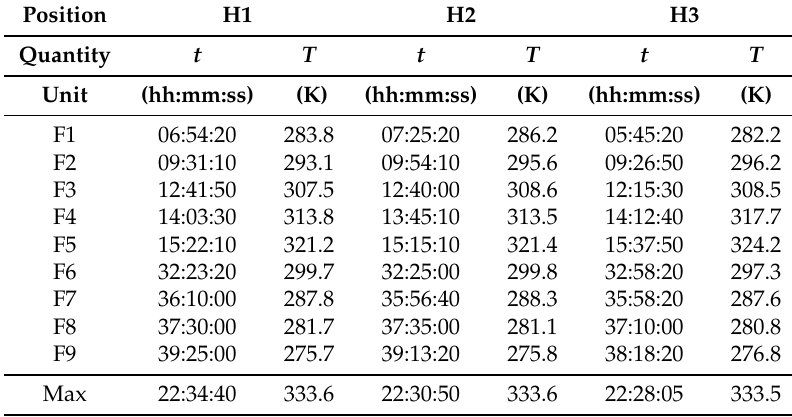
Table 6. Maxima and inflection points of the three average temperature trends at H1 = 1 cm, H2 = 3.5 cm and H3 = 6